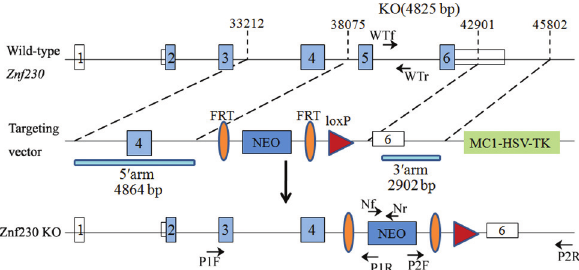
Figure 1 - The targeted knockout strategy for the Znf230 gene: wild-type allele, targeting construct and targeted allele with the location of primers. Primer pairs P1F/P1R and P2F/P2R, respectively, which flanked the tar- geted region, were used to select positive ESC clones, and were used to monitor the inheritance of the mutant allele. Primers WTf and WTr were used to amplify the wild-type Znf230 allele. Primers Nf and Nr were used to amplify the knockout